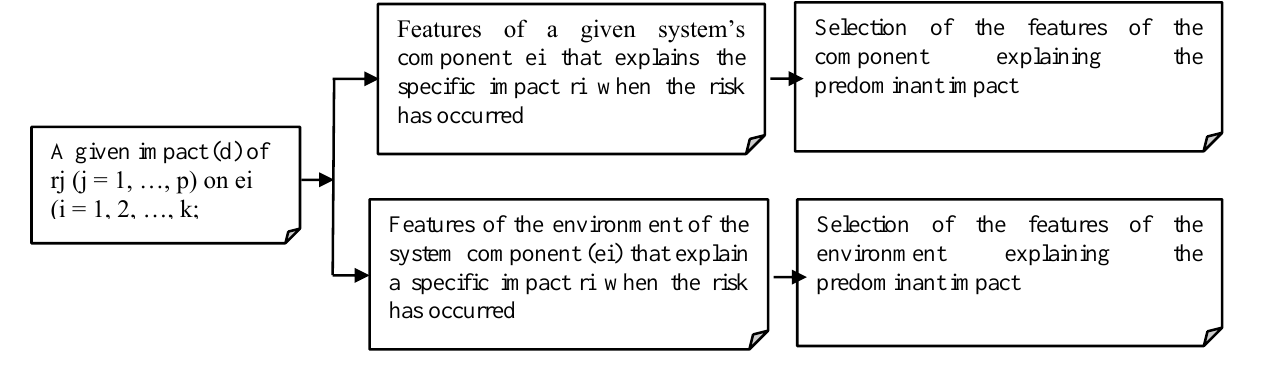
Figure 4. Process to identify vulnerability